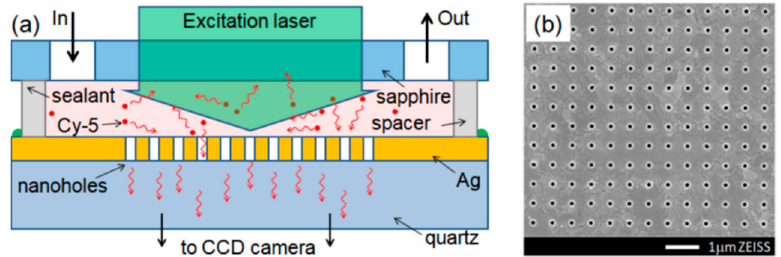
Figure 7. ( a ) Schematic diagram of the sensor, ( b ) SEM image of the nanohole array based on a 100 Ag thin film. Adapted from [92], with permission © 2018 Optical Society of nm Ag thin film. Adapted from [92], with permission © 2018 Optical Society of America.